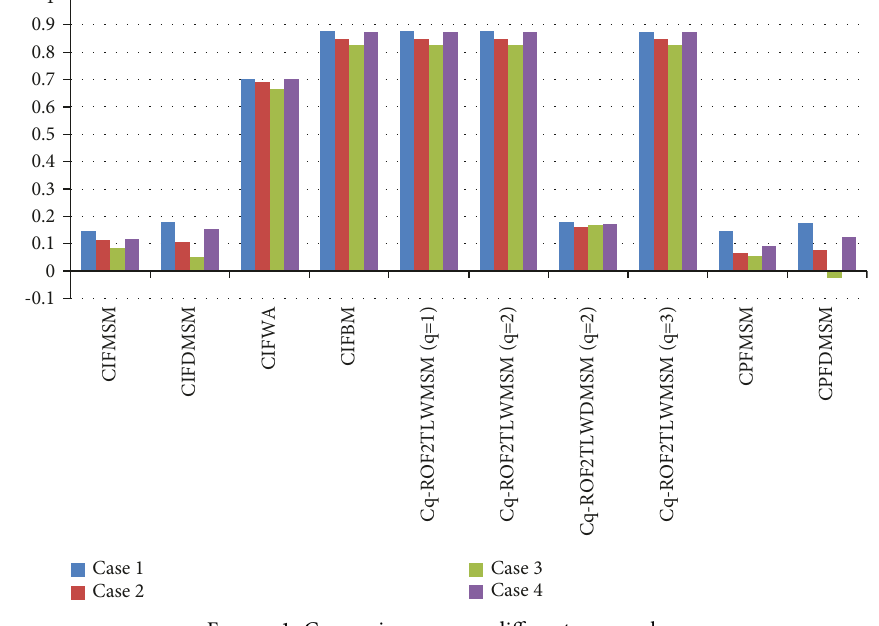
Figure 1: Comparison among different